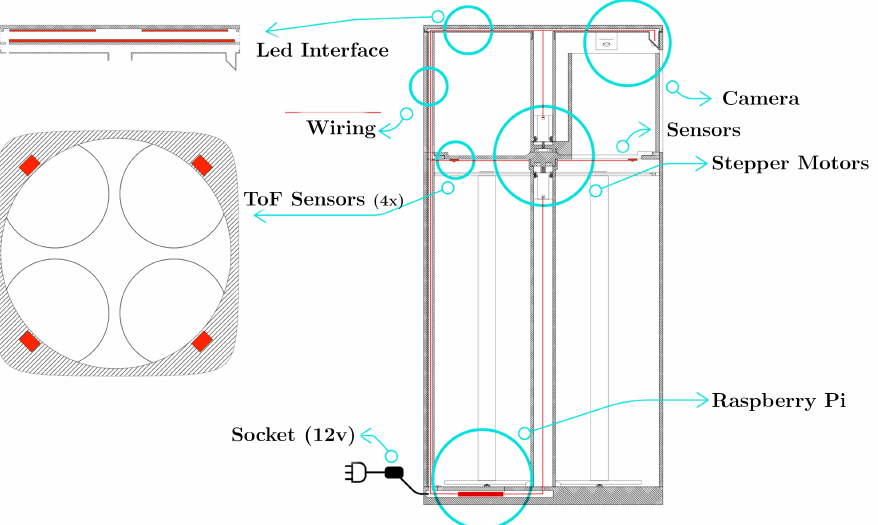
Figure 6. SWB vertical section and internal